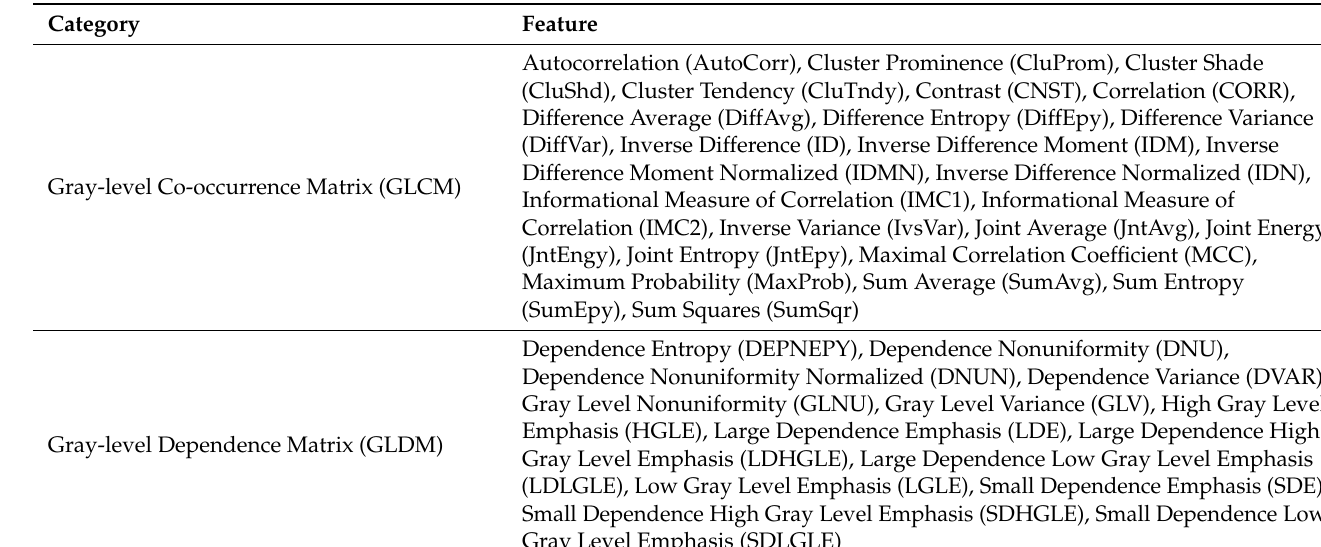
Table 2. Radiomics features being